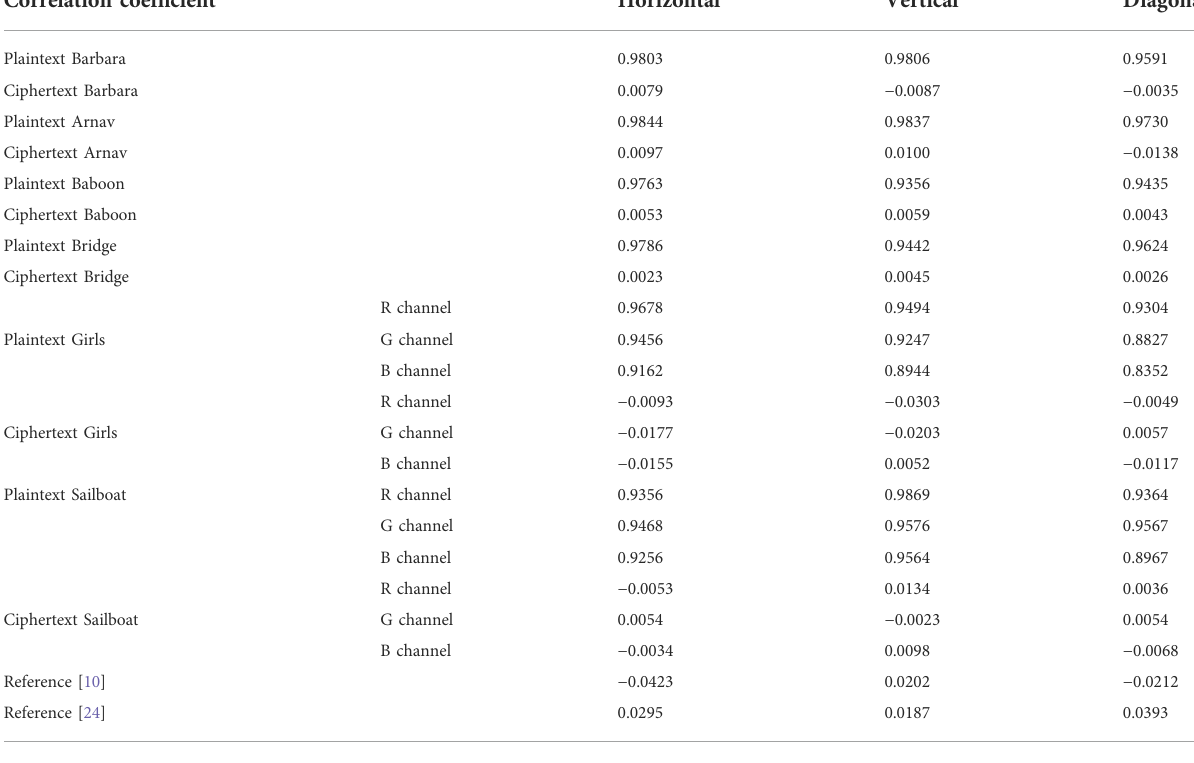
TABLE 3 Correlation coef fi cients of adjacent pixels. Correlation coef fi